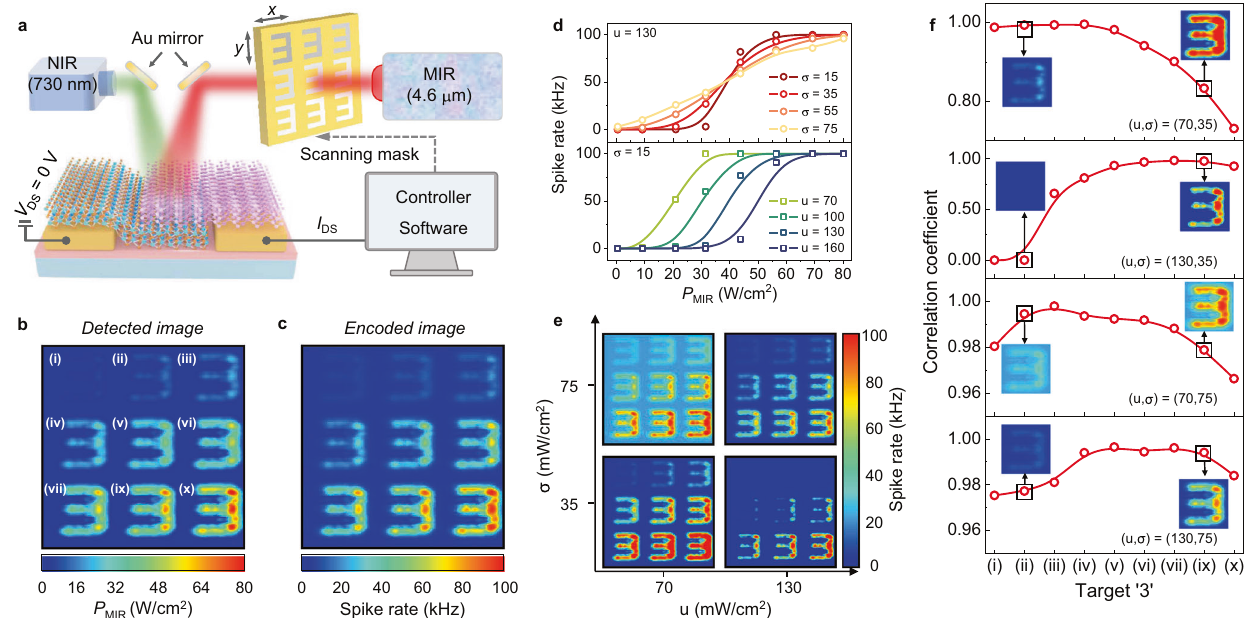
Fig.3|Visualadaptionofthe2DMIRoptoelectronicretinaforMIRtargetswith different opticalpower. a Schematic diagram oftest setup for the optoelectronic retinatoperceiveandencodetheMIRtargets.A2D-moveablemetalmaskprovides nine “ 3 ” -shapedMIRtargetswhoseaverageopticalpowerdensity( P MIR )arelinearly distributed within 0 to 80.21W/cm 2 by adjusting the output optical power